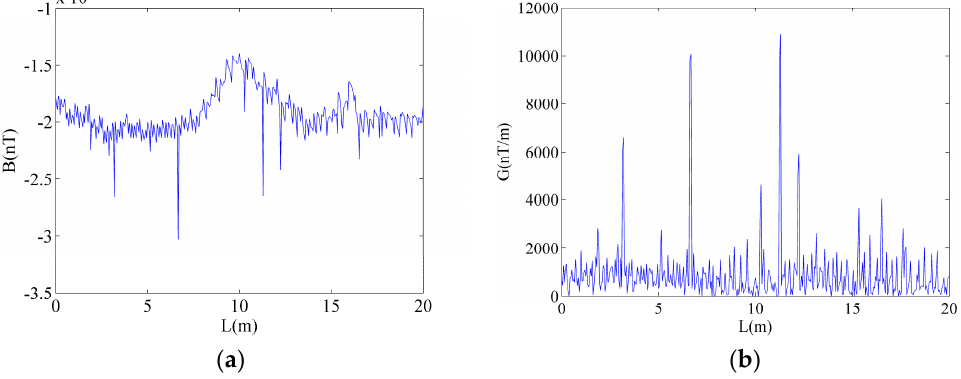
Electronics 2019 , 8 , x FOR PEER REVIEW Figure 8. The magnetic detection signal. ( a ) Original signal. ( b ) Gradient signal.